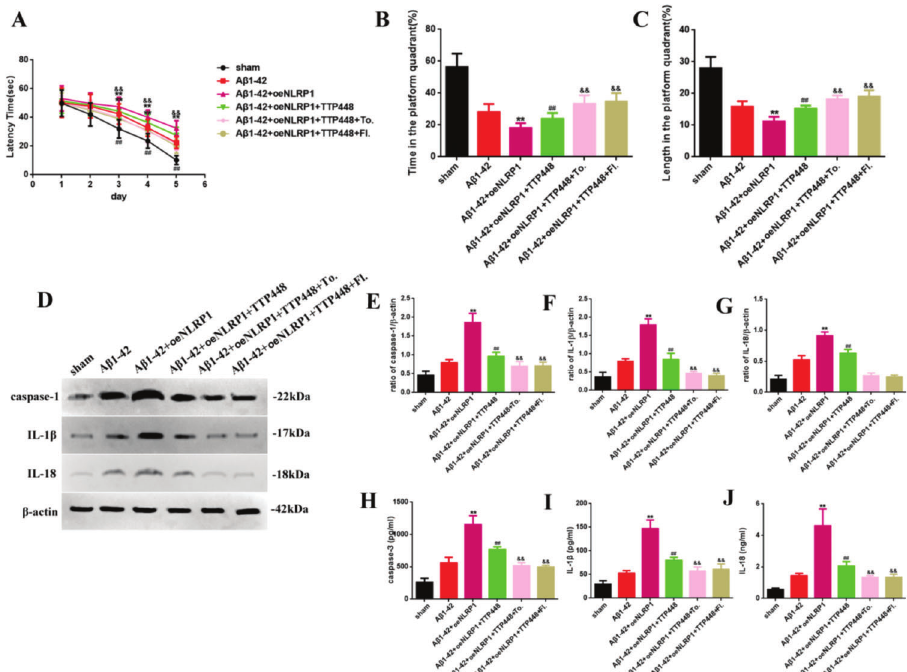
Figure 5 - (A) The latency time of, (B) the time spent by, and (C) the length covered by, mice in the platform quadrant in the Morris water maze. (D) Western blot assay for detecting the expression of caspase-1, IL-1 b , and IL-18. (E–G) Quantification of the levels of caspase-1, IL-1 b , and IL-18. (H–J) ELISA assay for quantifying the expression levels of caspase-1, IL-1 b , and IL-18 in the sham, A b 1-42, A b 1- 42 + oeNLRP1, A b 1-42 + oeNLRP1 + TTP488, A b 1-42 + oeNLRP1 + TTP488 + Tofacitinib, and A b 1-42 + oeNLRP1 + TTP488 + Fludarabine groups. Protein levels were normalized to those of b -actin (A b 1-42 + oeNLRP1 vs . A b 1-42 group, ** p o 0.05; A b 1-42 + oeNLRP1 + TTP488 vs . A b 1-42 + oeNLRP1 group, ## p o 0.05; A b 1-42 + oeNLRP1 + TTP488 + Tofacitinib or A b 1-42 + oeNLRP1 + TTP488 + Fludarabine vs . A b 1-42 + oeNLRP1 + TTP488 group, && p o 0.05, n=6 per